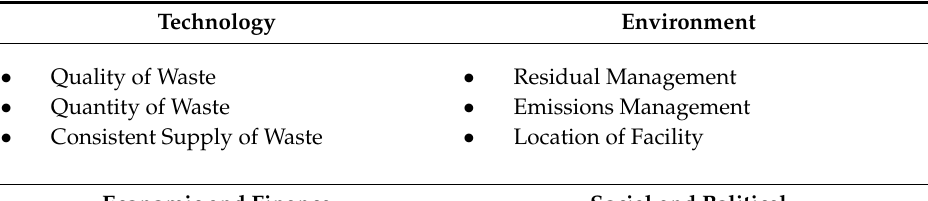
Table 5. Summary of the technical, economic, environmental, and social issues relating to the